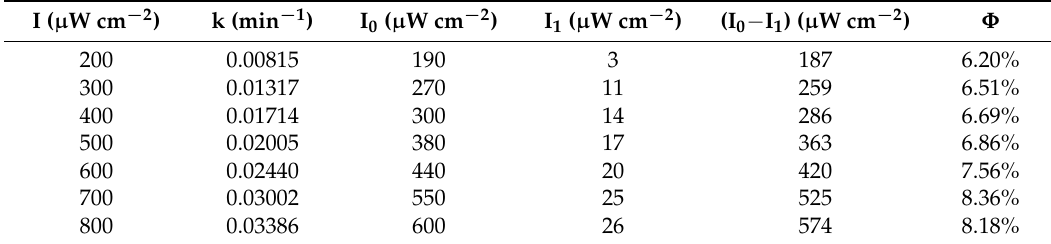
The effect of varying the light intensity on the quantum yield ( Φ ) of RPE during its